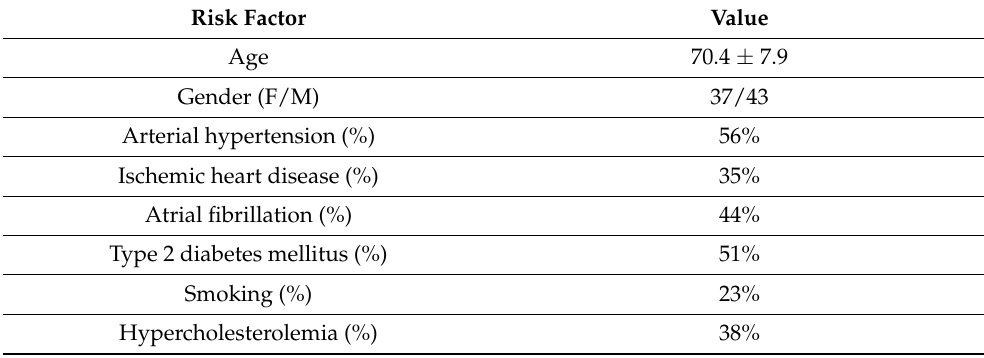
Table 1. Demographic